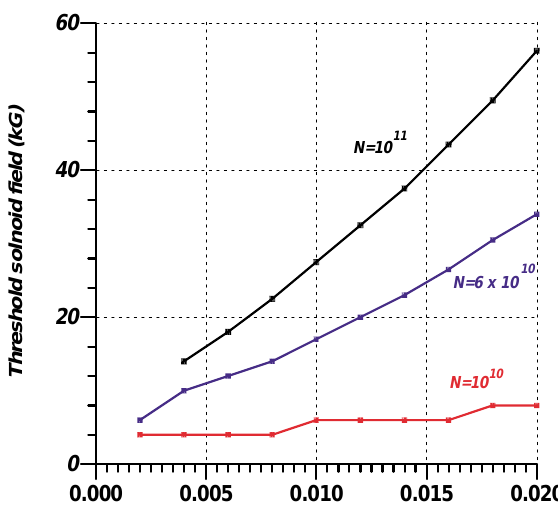
FIG. 15. (Color) Threshold solenoid field B thr vs tune shift due to electrons j j e j at different bunch populations N ¯ p (cid:1) 1, 6, 10 3 10 10 . Focusing lattice tunes n x (cid:1) 0.585 , n y (cid:1) 0.575 , synchrotron tune n s (cid:1) 0.0012 , no betatron tune spread in the beam, and the rms size of antiproton beam s ¯ p (cid:1) 0.7 mm.